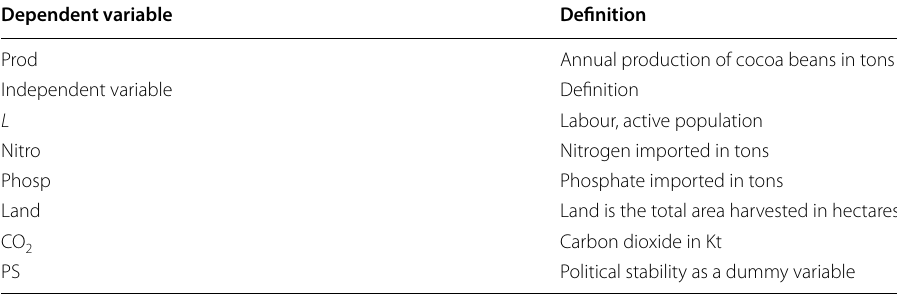
Table 1 Variables